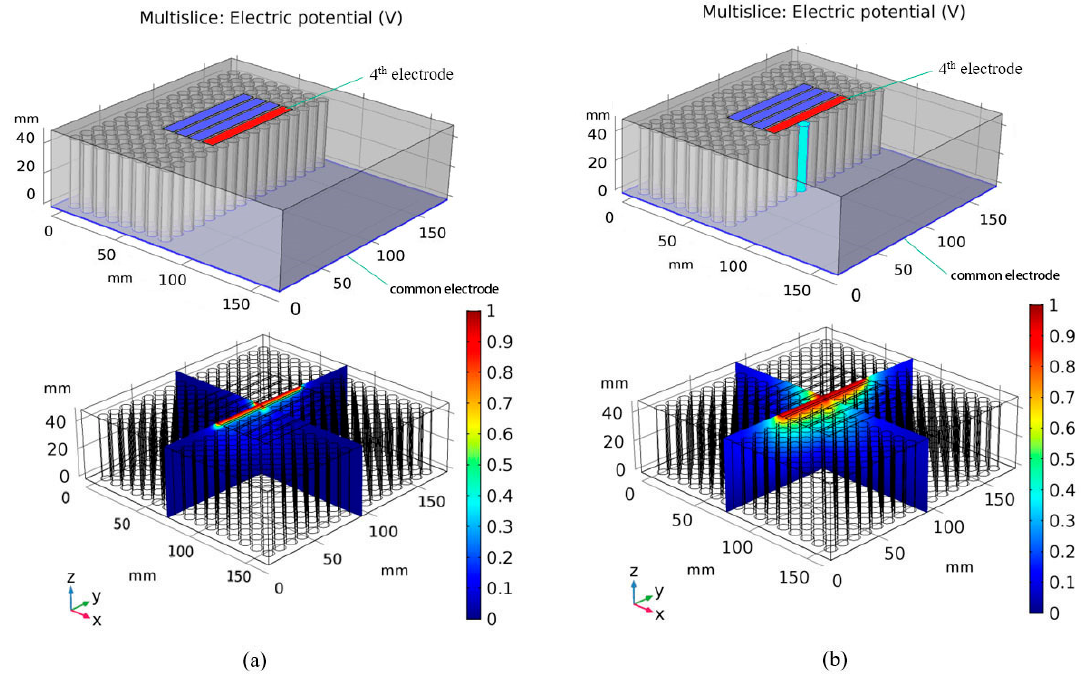
Figure 3. Electric potential distribution while the fourth electrode is activated. ( a ) All column holes have no water inside, ( b ) the central column hole is full of water.